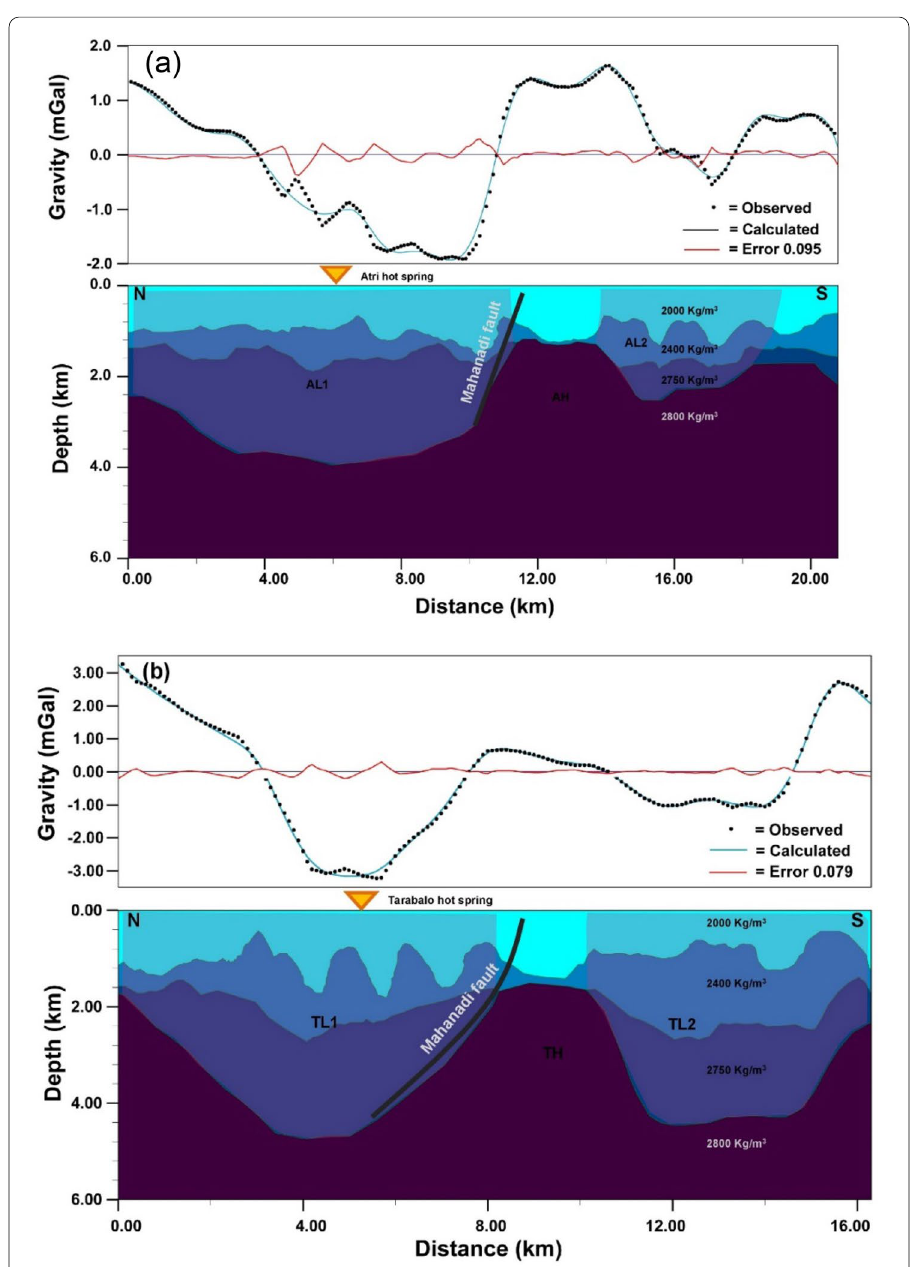
Fig. 7 2D forward gravity models along the profiles passing through the hot springs: a profile P1 through Atri hot spring; b profile P2 through Tarabalo hot spring. Shaded AL1, TL1, and AL2, TL2 denote low-density zones in the subsurface along profile P1 and P2, while AH and TH represent the locations of high-density zones beneath profile P1 and P2,